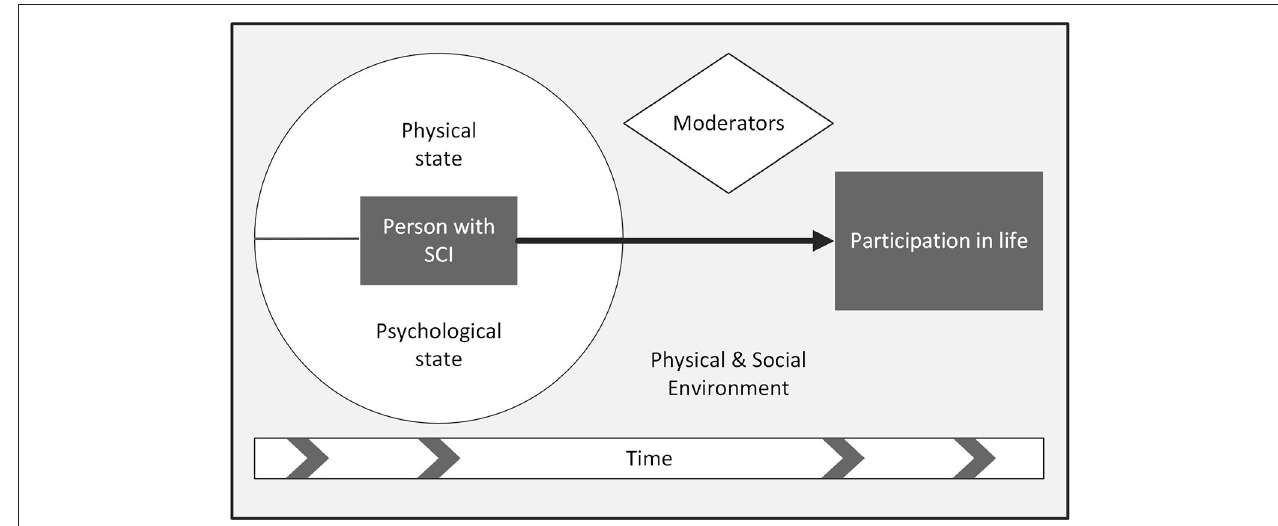
FIGURE 2 | Interconnected elements that influence participation after